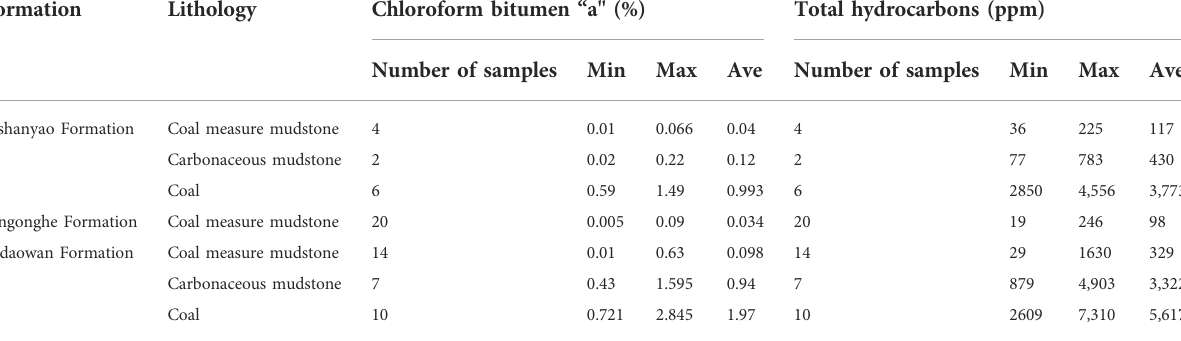
TABLE 3 Test results of chloroform bitumen “ A ” and total hydrocarbon content of Jurassic source rocks in the Yanqi Basin.